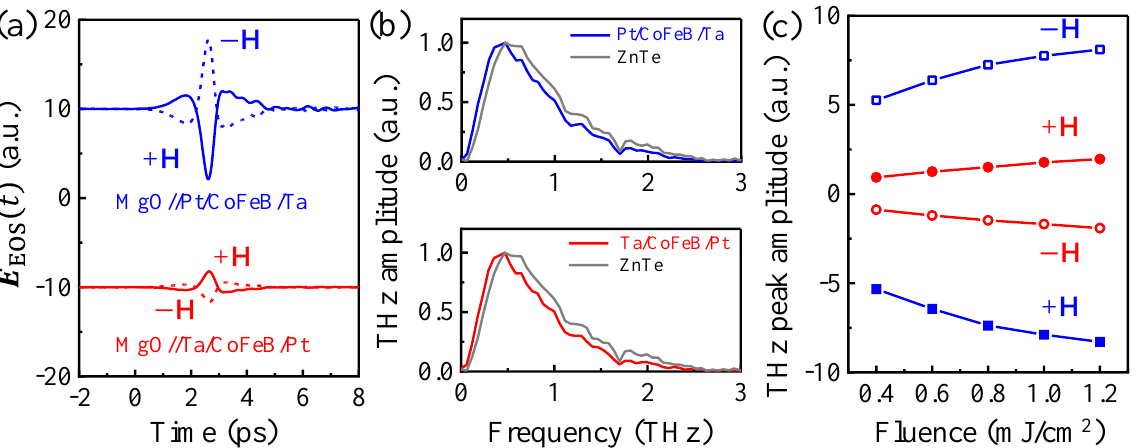
Figure 2. Terahertz waveforms at the different excitation geometries. ( a ) THz EOS waveforms E EOS ( t ) of the photoexcited MgO//Pt/CoFeB/Ta and MgO//Ta/CoFeB/Pt stacks. The zero-time delay corresponds to the arbitrary starting point. ( b ) The corresponding normalized Fourier transform of ( a ). The light-gray curve is the THz emission from a ZnTe crystal. ( c ) The pump fluence-dependence of THz peak amplitude from two samples at ± H . Damage is not observed in the samples at the maximum pump fluence used here.